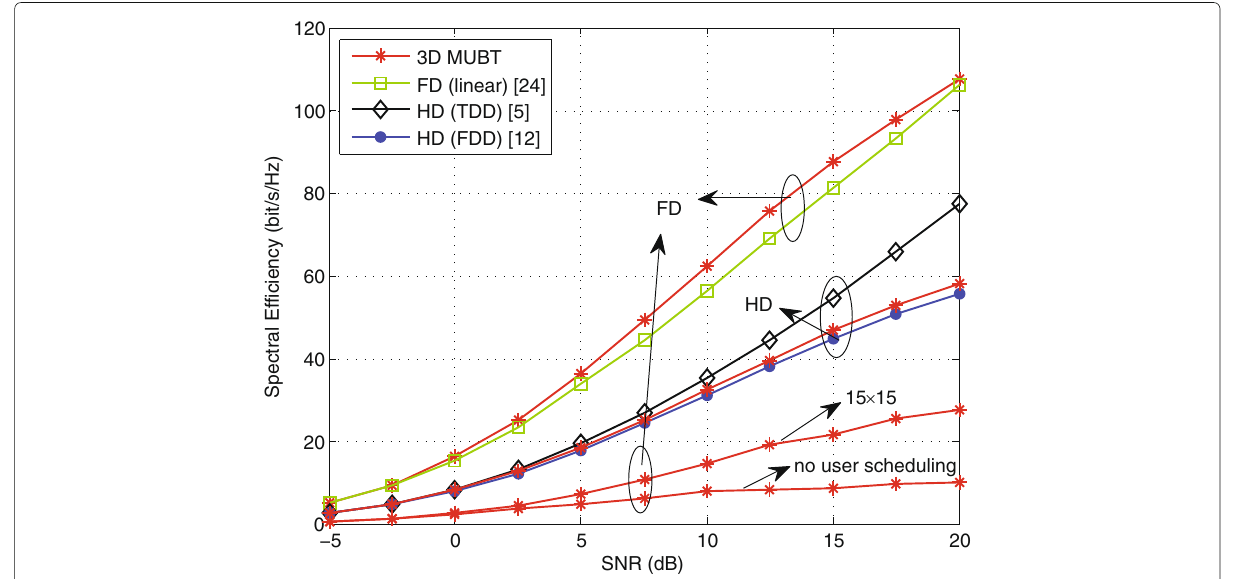
Fig. 6 SEs versus average receive SNRs in different scenarios